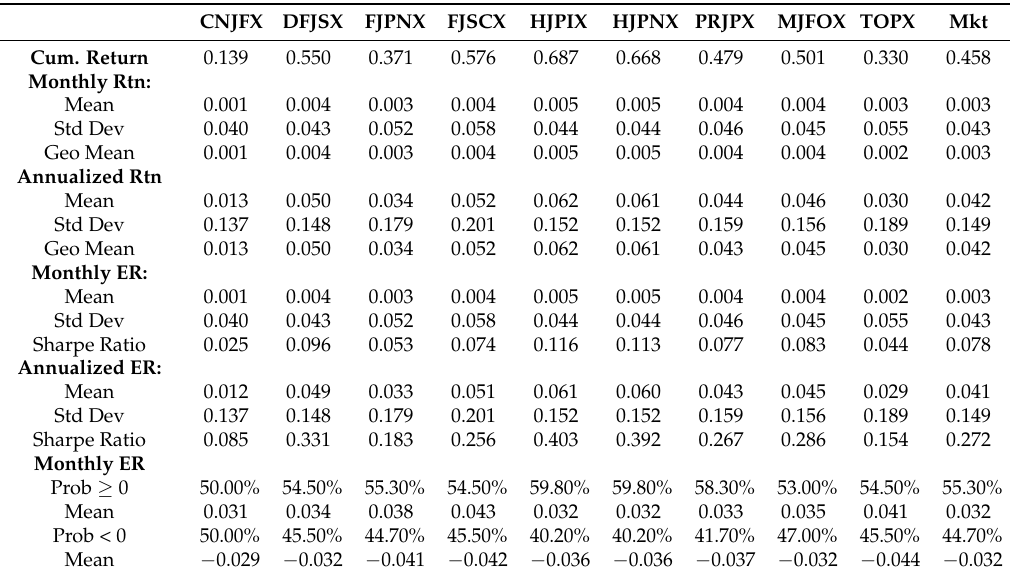
Table 3. Mutual funds’ return measurement from April 2005–March 2016. CNJFX DFJSX FJPNX FJSCX HJPIX HJPNX PRJPX MJFOX